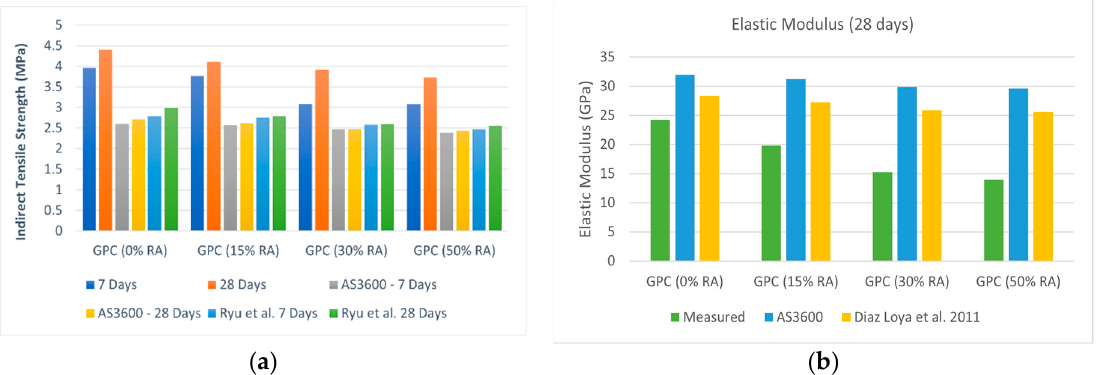
Figure 2. ( a ) Indirect tensile strength of GPC containing different percentages of NA and RA [27]; and ( b ) elastic modulus of GPC containing NA and RA [25,28].